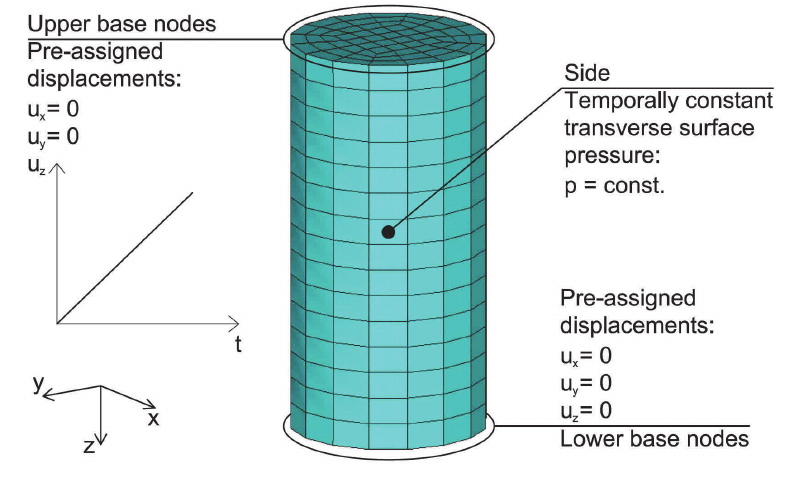
Figure 2: The computational